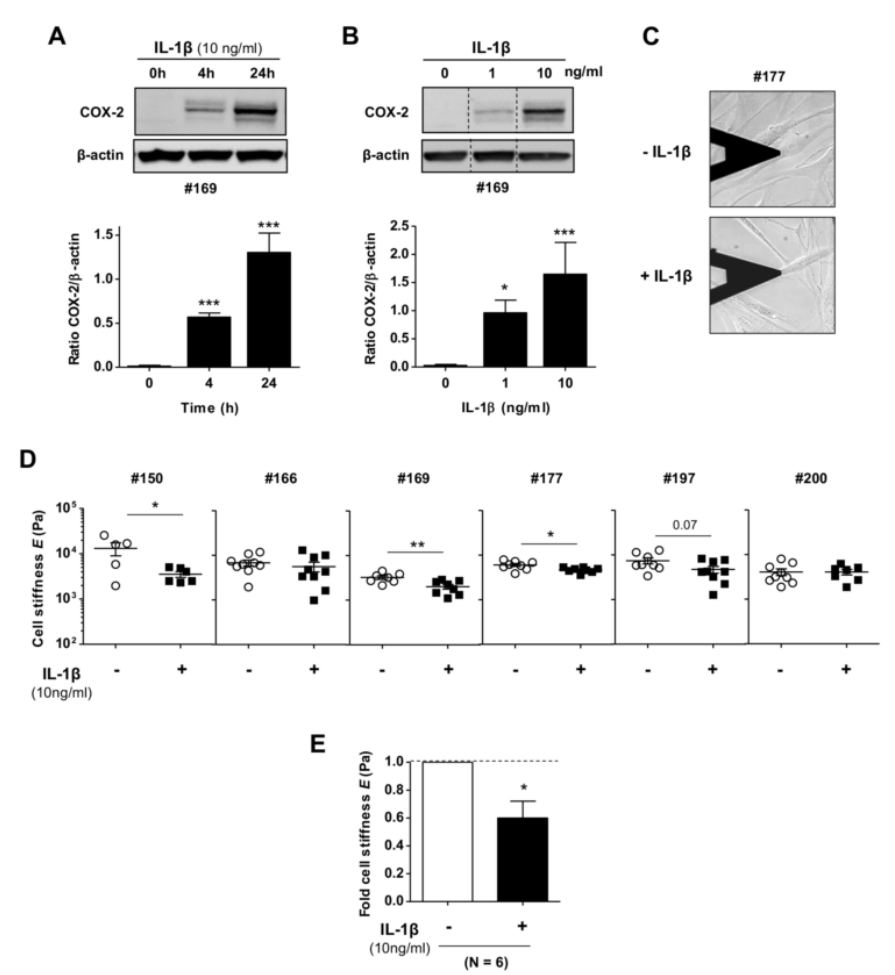
Figure 1. E ff ect of interleukin-1 β (IL-1 β ) stimulation on the sti ff ness of primary human